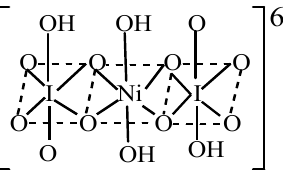
6 − complex 2 (HIO 6 ) 2 ]